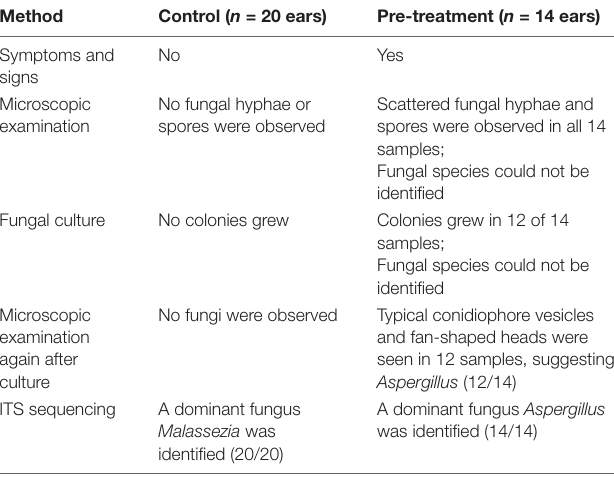
TABLE 5 | Comparison of different methods for fungal identification in the present